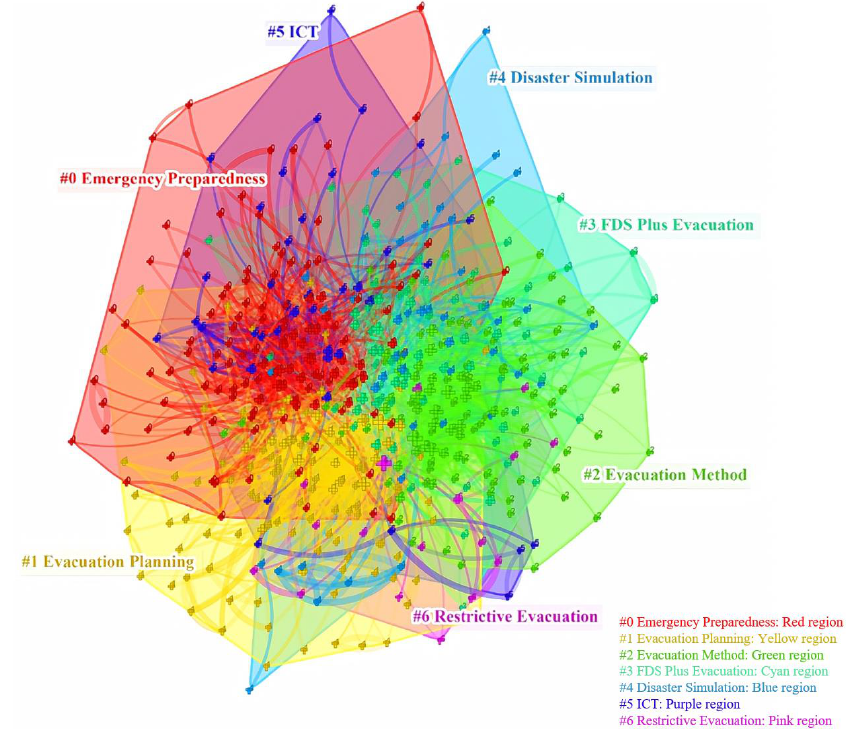
Figure 7. Clustering analysis of keywords.